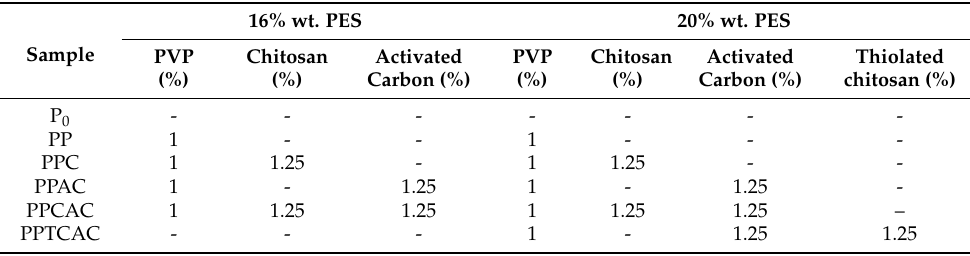
Table 1. Composition of the polyethersulfone